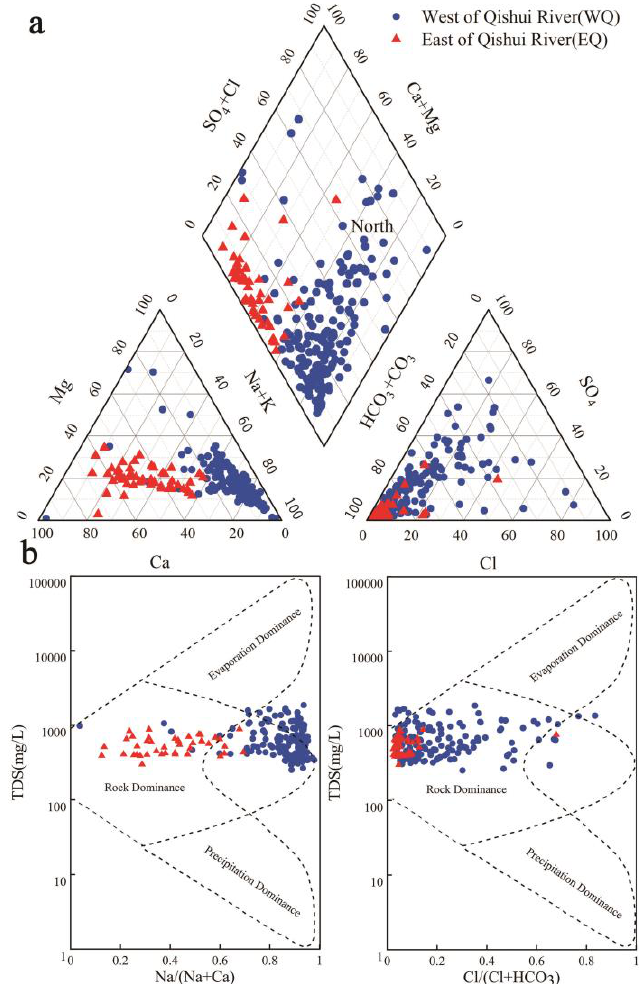
Figure 2. Piper ( a ) and Gibbs ( b ) diagrams representing groundwater types for different groundwater groups.